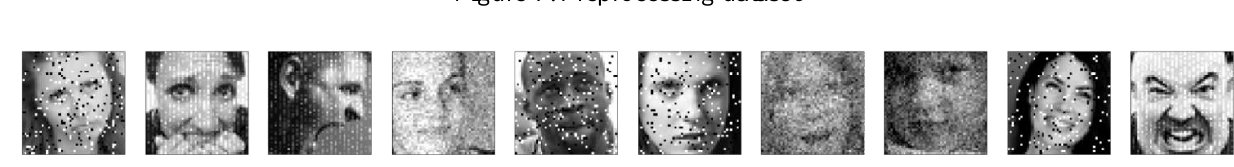
Figure 7. Preprocessing dataset